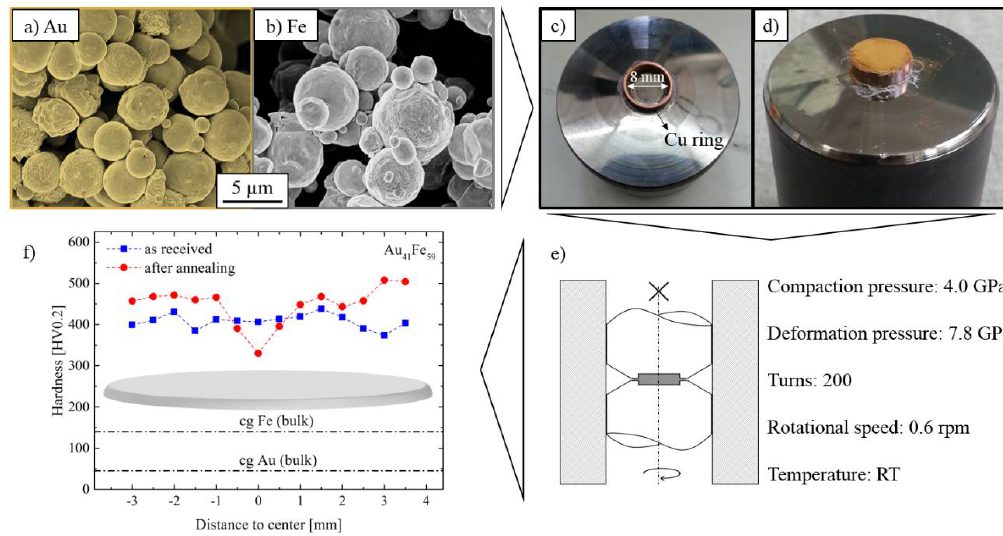
Figure 1. Scanning electron microscope (SEM) images of ( a ) Au powder (image colored ex post) and ( b ) Fe powder used as a base material for the composite precursor; ( c ) Lower anvil of the HPT setup with affixed Cu ring used ( d ) as powder container; ( e ) Scheme of HPT with used compaction and deformation parameters; ( f ) Microhardness measurements of the deformed Au 41 Fe 59 composites show a softening in the center and hardening closer to the edge upon annealing.